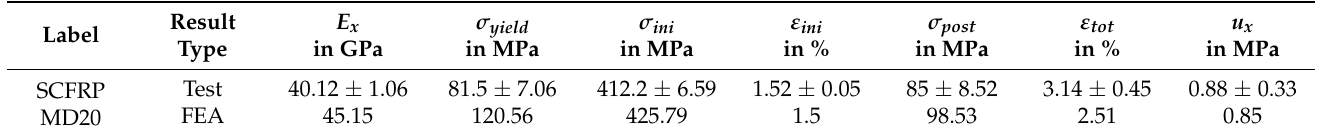
Figure 9. Experimentally determined and numerically predicted stress–strain behavior for a multidi- rectional SCFRP with a steel fiber volume fraction of approx. 20%. Table 5. Experimentally determined and numerically predicted mechanical properties for a multidi- rectional SCFRP with a steel fiber volume fraction of approx.